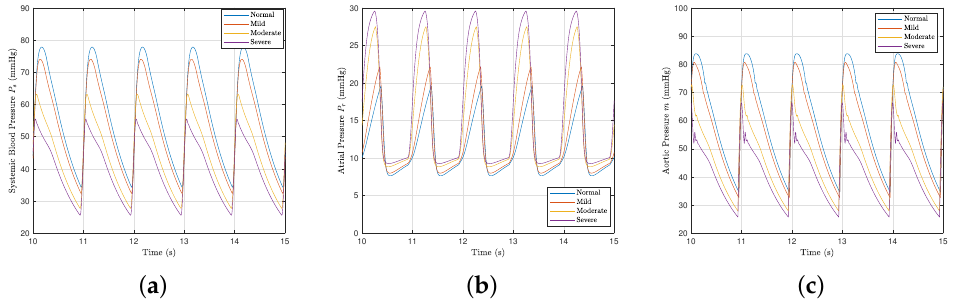
Figure 4. The systemic, atrial, and aortic pressures with different severities of mitral valve regurgita- tion. ( a ) Systemic blood pressure P s . ( b ) Atrial pressure P r . ( c ) Aortic pressure m .